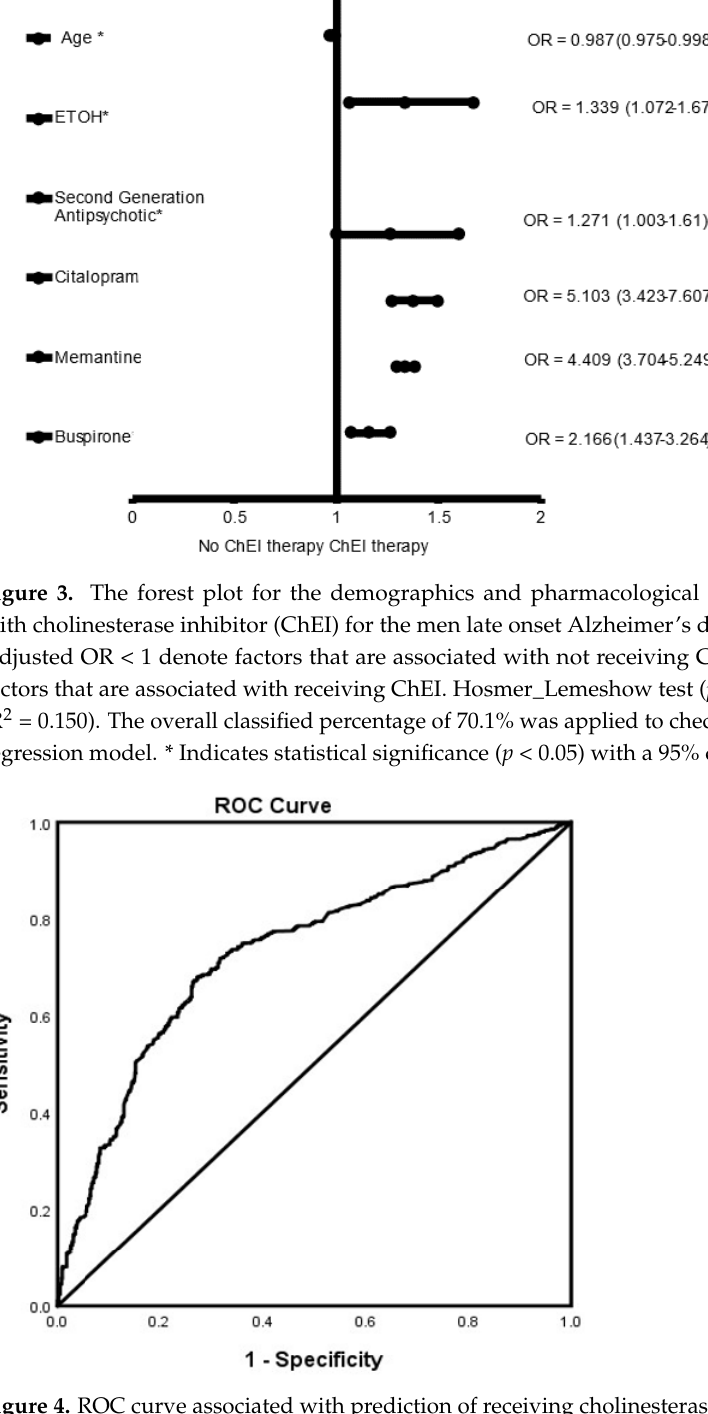
Figure 4. ROC curve associated with prediction of receiving cholinesterase inhibitor (ChEI) for men late onset Alzheimer’s patients. Higher area under the curve (AUC) values in ROC analysis indicate better discrimination of the score for the measured outcome. Classification table (overall correctly classified percentage = 70.1%) and area under the ROC curve (AUC = 0.730, 0.711–0.749) were applied to check model fitness.